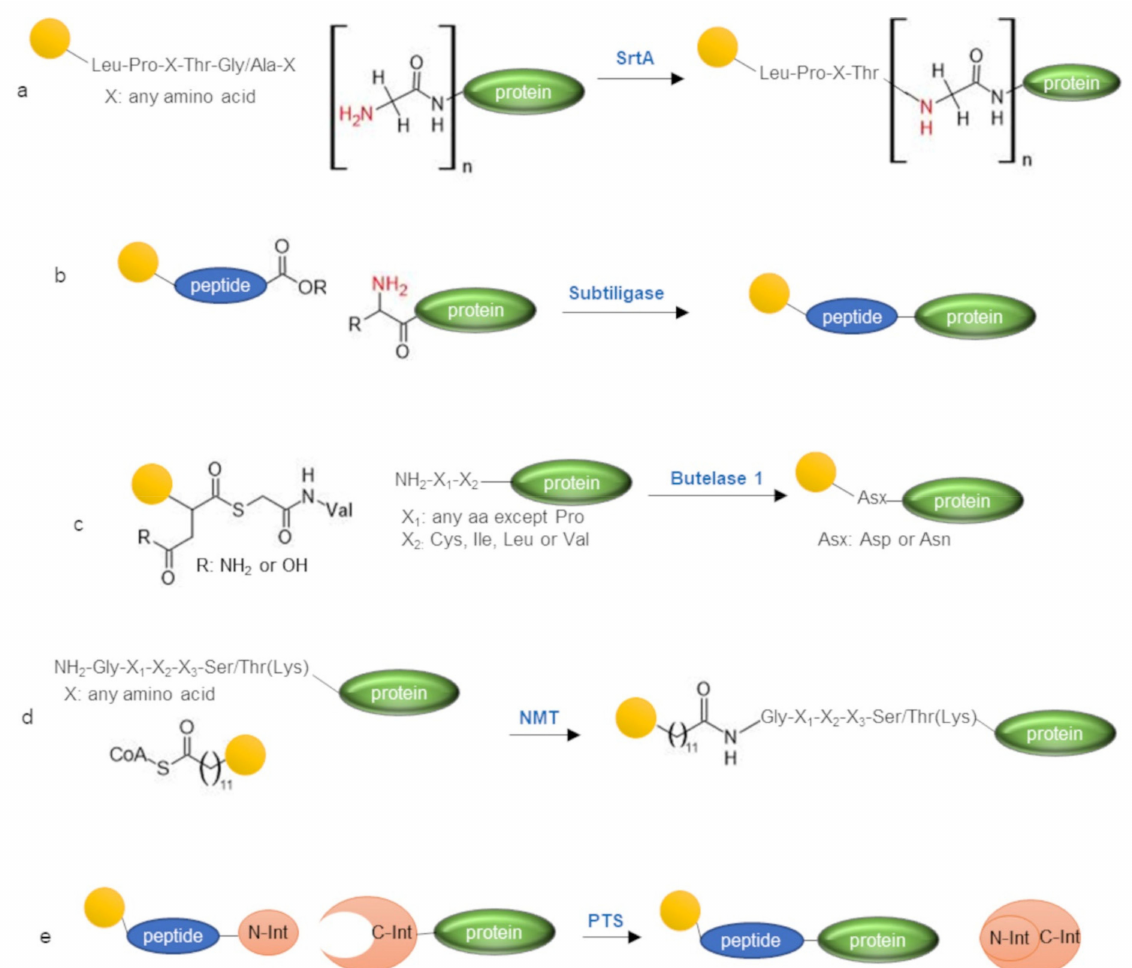
Figure 6. Enzyme-catalyzed N-terminal protein labeling. N-terminal protein modification mediated by ( a ) sortase A (SrtA); ( b ) subtiligase; ( c ) N- Myristoyltransferase (NMT); ( d ) butelase 1; ( e ) protein trans-splicing (PTS). Aa, amino acid; CoA, coenzyme-A; N-Int, N-terminal domain of a split intein; C-Int, C-terminal domain of a split